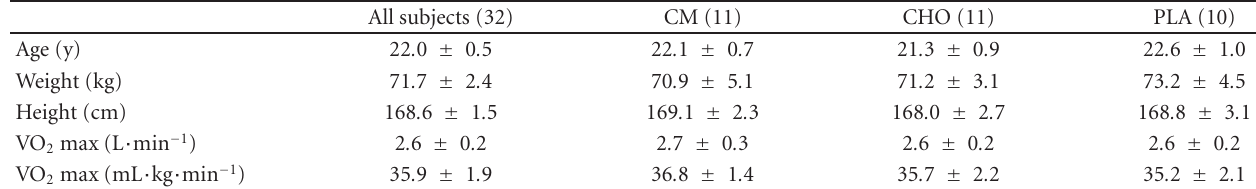
Table 1: Subject characteristics at baseline.